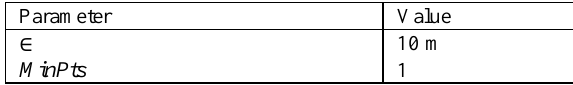
Table 3 . Clustering parameter